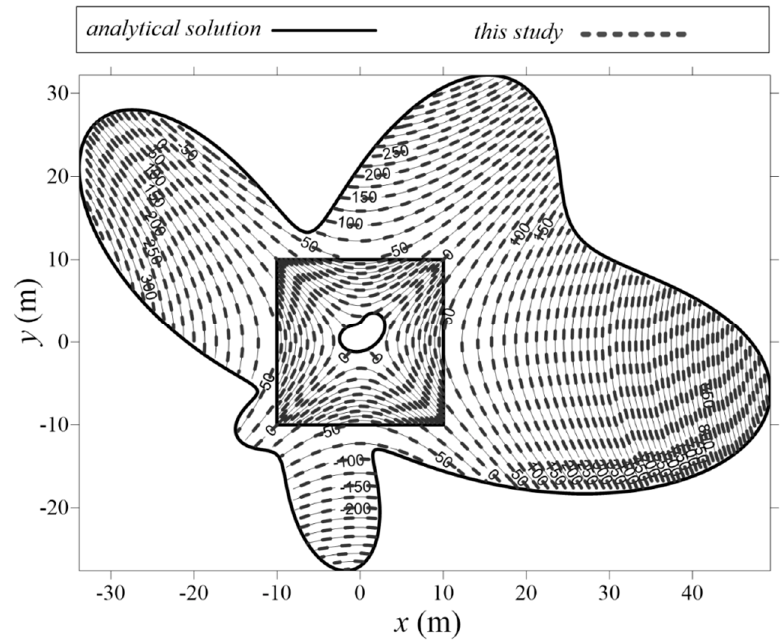
Figure 21. The comparison of temperature distribution with the analytical solution.